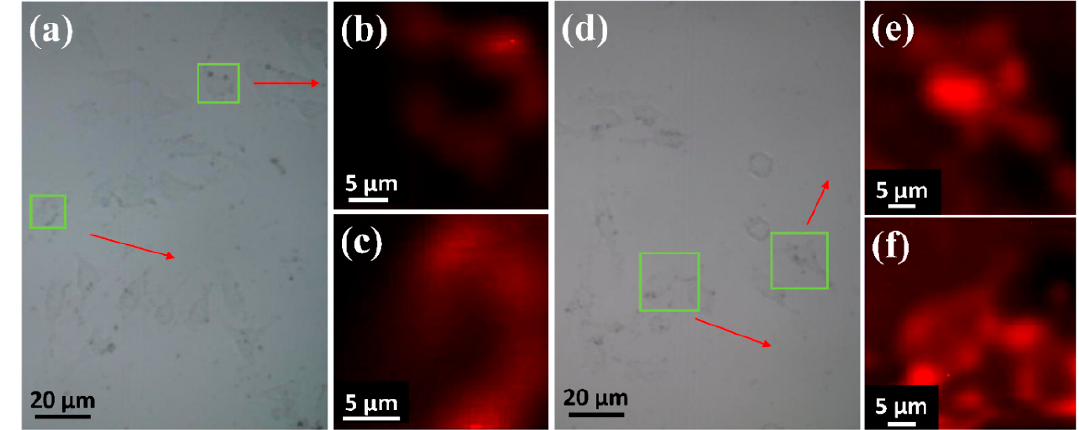
Figure 4. SERS images of HeLa cells incubated with nanoprobes. ( a – c ) AuNPC; ( d – f ) AuNPC-RGD. SERS images at the Raman shift of 1065–1080 cm − 1 were obtained under the laser of 633 nm. Compared with Raman scattering signals, fluorescence signals are stronger and more sensitive